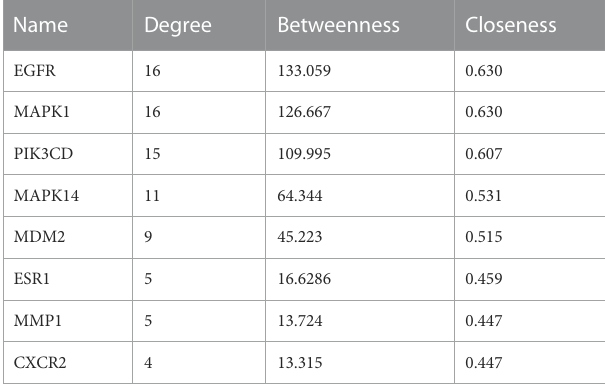
TABLE 4 Top ten targets information of PPI